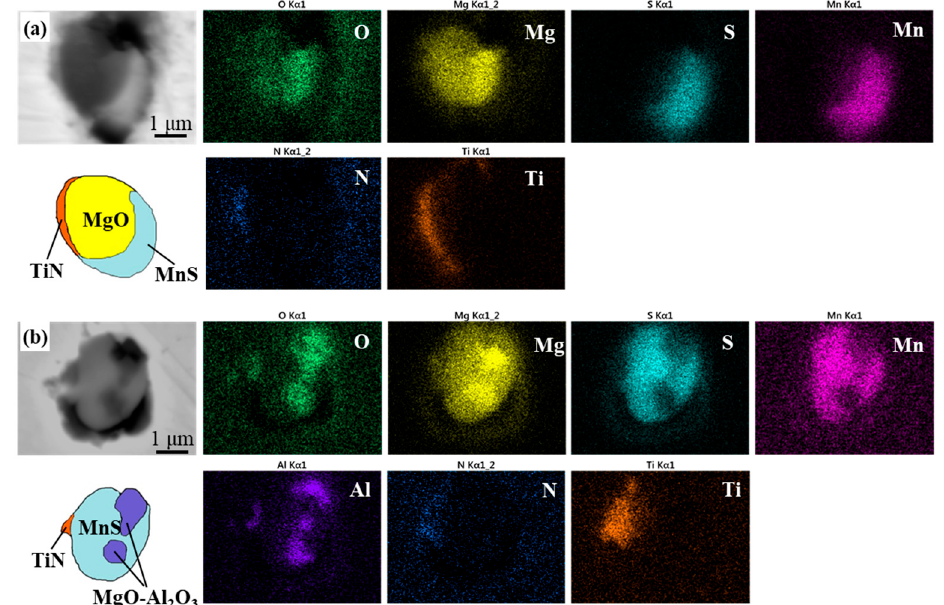
Figure 4. Morphology and composition of typical inclusions. ( a ) MgO-MnS-TiN in 3Mg1Al; ( b ) MgO-Al 2 O 3 -MnS-TiN in 3Mg20Al.